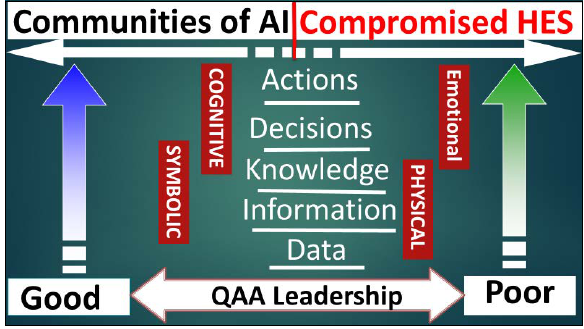
Continuum and effects of quality assurance agency (QAA)